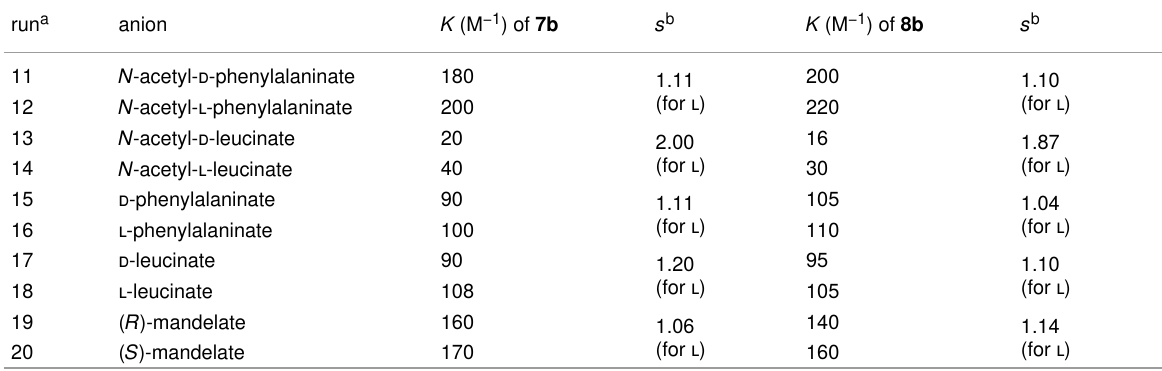
Table 2: Binding constants of the receptors 7b and 8b towards selected anions ( 1 H NMR titration, 400 MHz, DMSO- d 6 , 298 K). run a